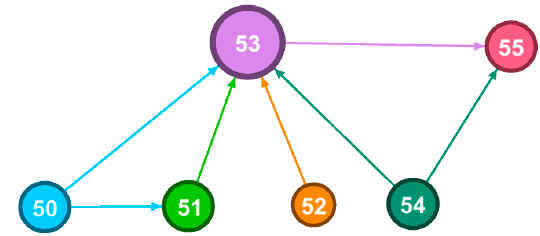
Figure 11. Six key stages of the network model.